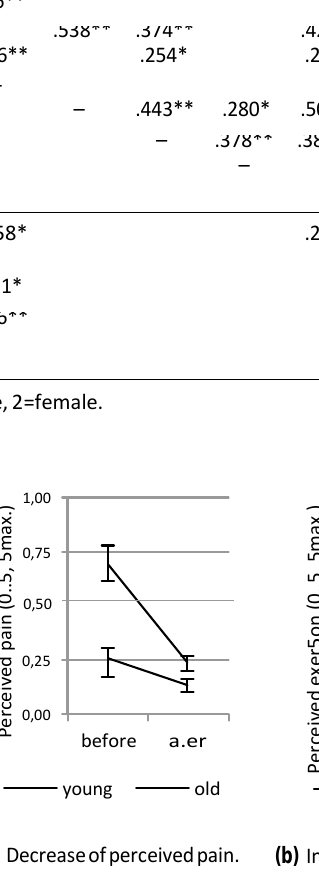
In-game Performance (PERF)